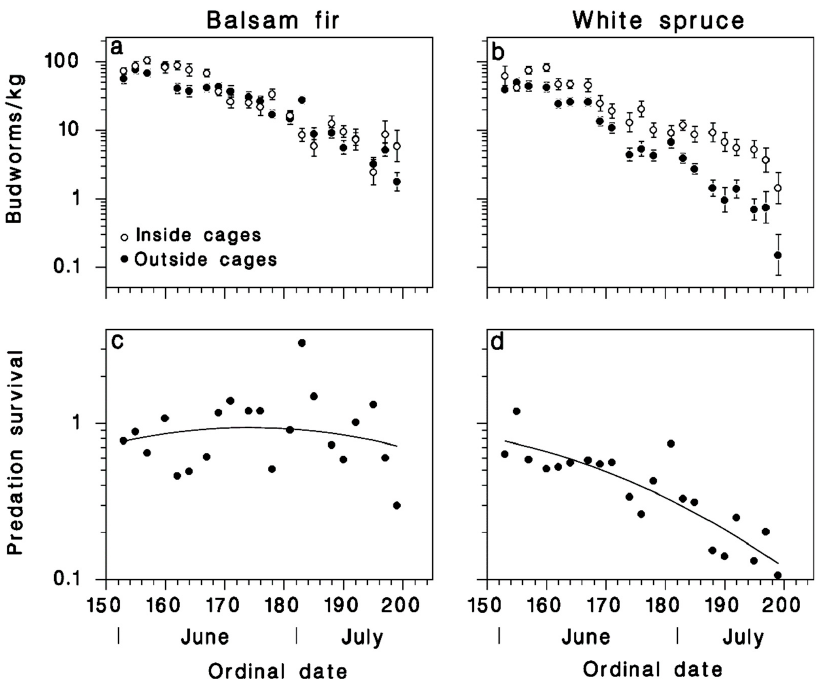
Figure 3. Seasonal changes of spruce budworm density and survival from predation in Armagh in 1986 on ( a , c ) balsam fir and ( b , d ) white spruce (means ± SEM). ( c , d ) symbols: observed survival from predation (Equation (1)), lines: survival predicted with Equation (6).